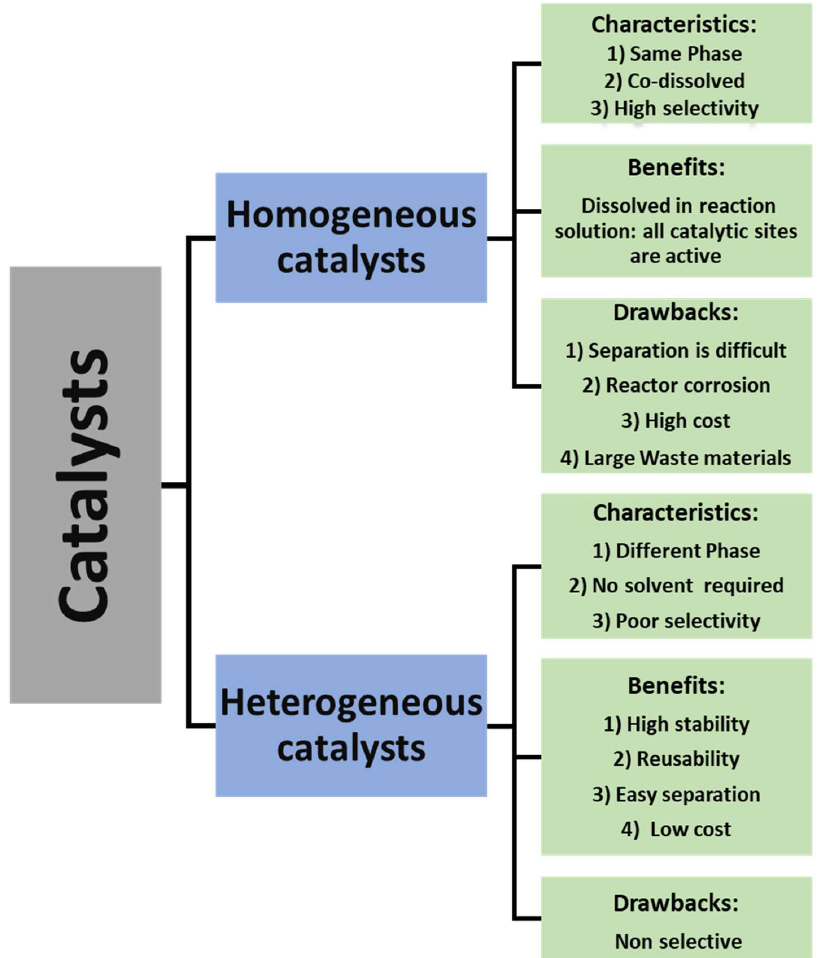
Figure 1. Characteristics, benefits, and drawbacks of homogeneous and heterogeneous catalysts.